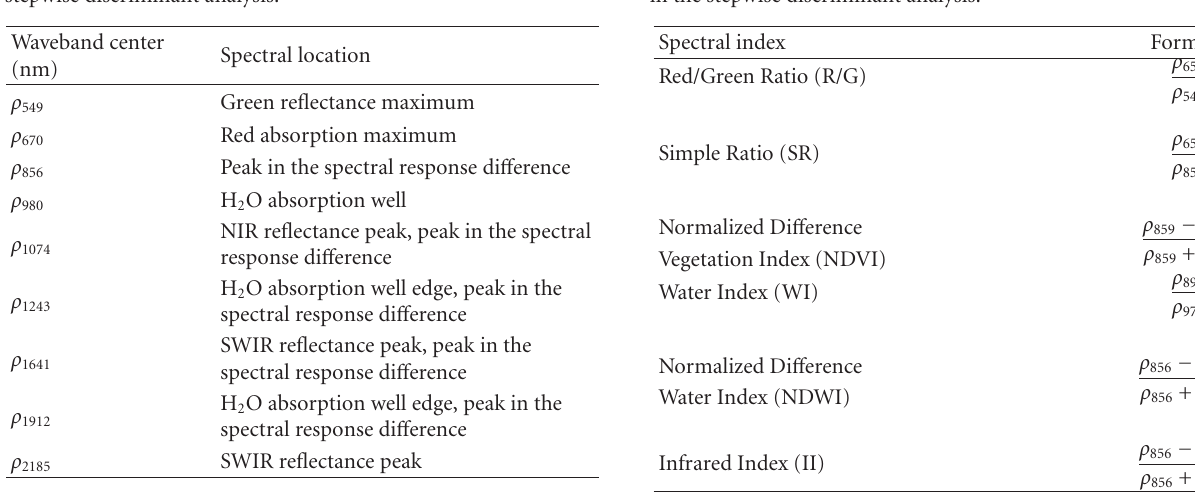
Table 3: Narrow waveband spectral indices available for selection in the stepwise discriminant